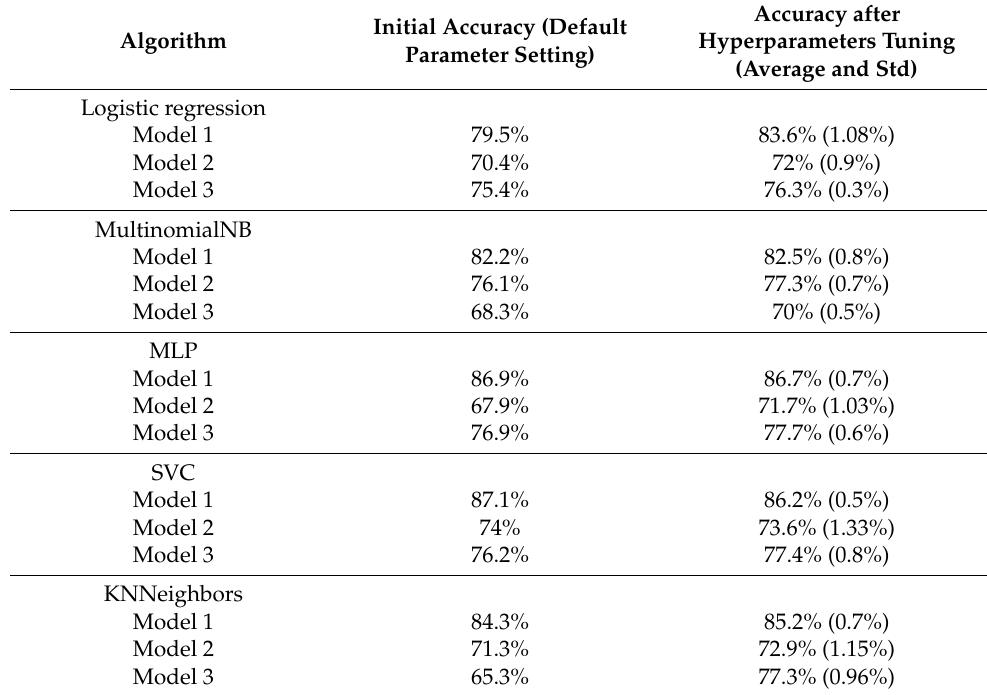
Table 4. The average accuracies of algorithms before and after the hyperparameter